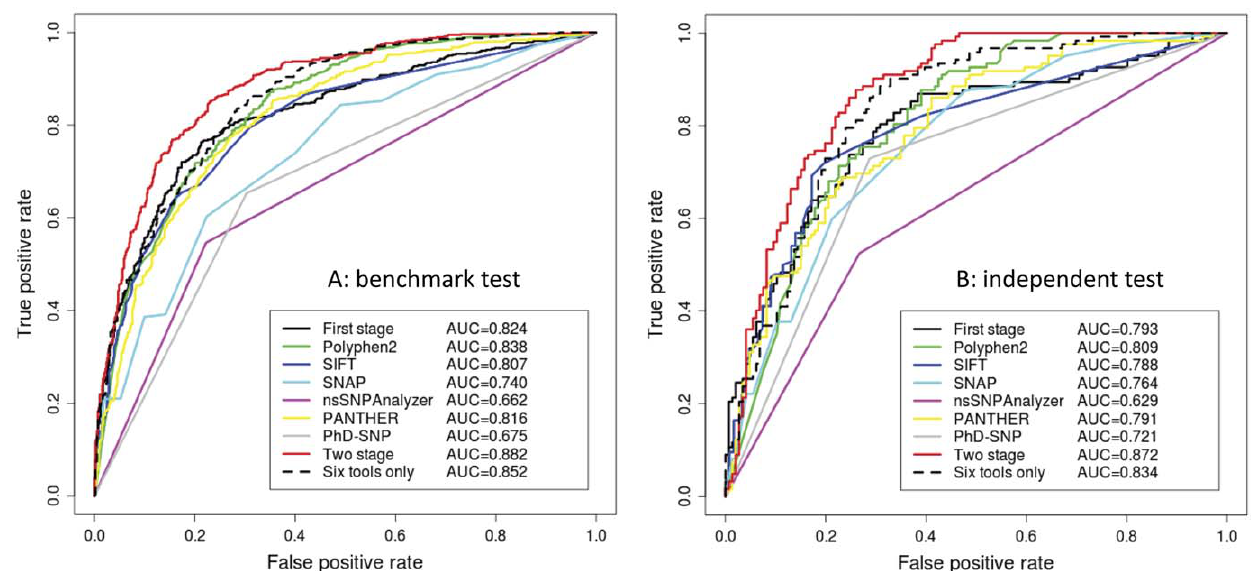
Figure 5. The ROC curves of nine classifiers based on 5-fold cross-validation tests. Results are evaluated based on the benchmark dataset (A) and independent test dataset (B).